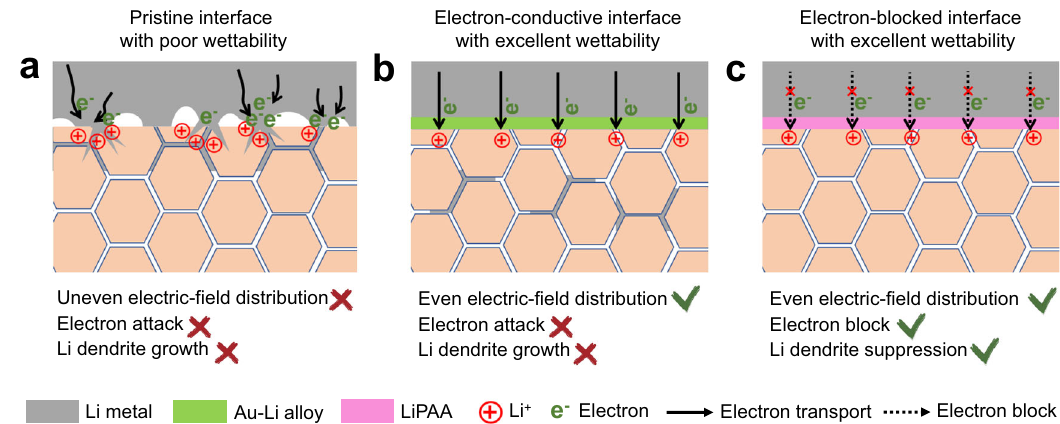
Fig. 6 Schematic illustrations of Li dendrite growth at various interfaces. Schematic illustrations of Li dendrite growth at the a pristine LLZTO/Li interface, b LLZTO@Au/Li interface, and c